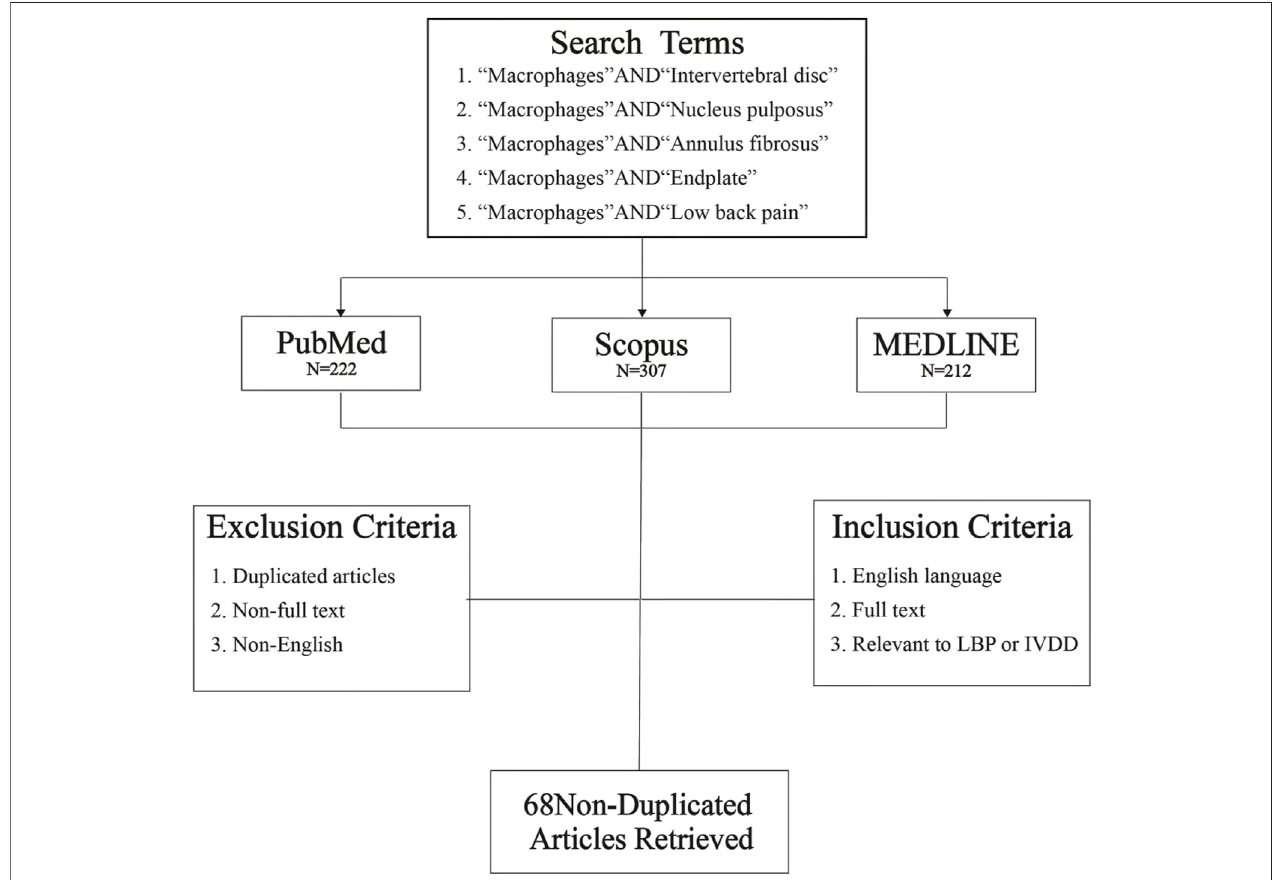
FIGURE 1 | Database search fl owchart. Five independent literature searches were conducted using de fi ned search terms through three literature databases, and the identi fi ed articles were screened for exclusion or inclusion. Then, 741 articles were obtained from the initial database search; after screening, 68 non-duplicated original research articles were included in this